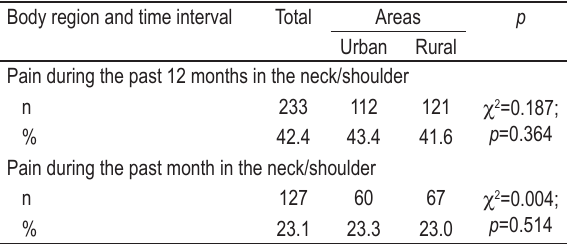
TABLE 3. The review of respondents with the pain in the neck/shoulder Body region and time interval Total Areas